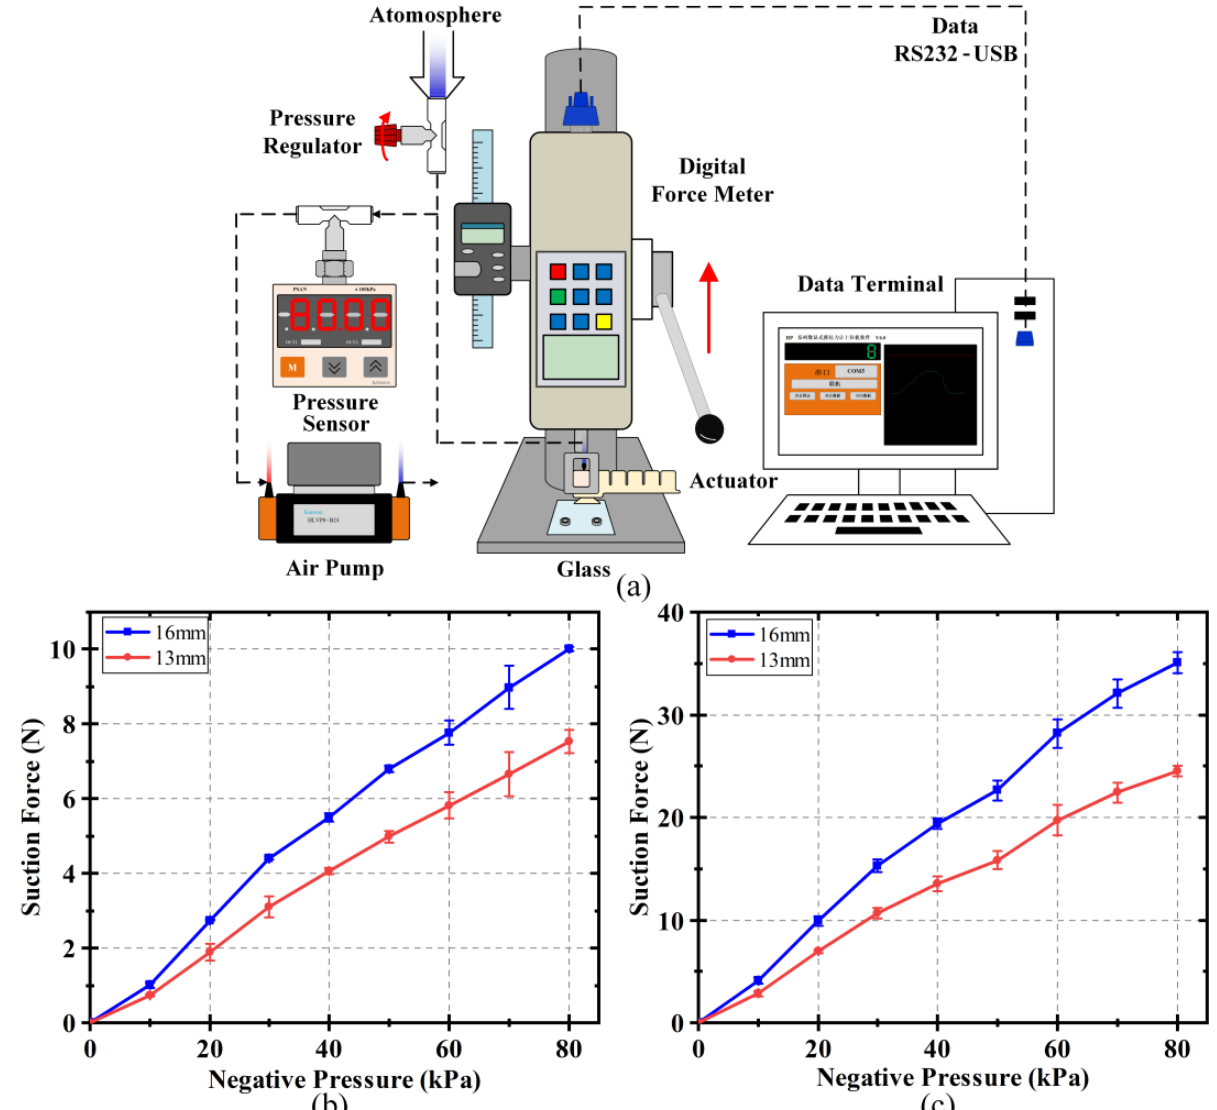
Figure 8. Suction force test. ( a ) Schematic diagram of the experimental setup. Suction forces under different negative pressure inputs when using ( b ) a single suction pad and ( c ) four suction pads.